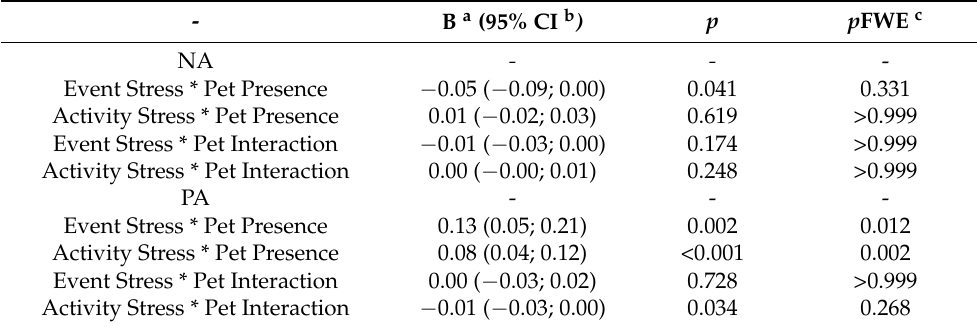
Table 3. Interaction between companion animal (presence and interaction) and stress (activity related and event related) in the model of NA and PA (buffering model). - B a (95% CI b